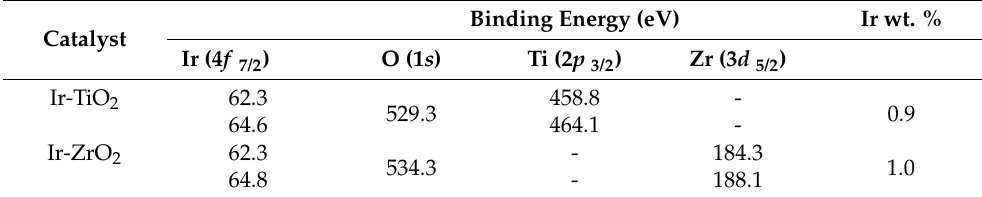
Table 2. XPS binding energies of the Ir-TiO 2 and Ir-ZrO 2